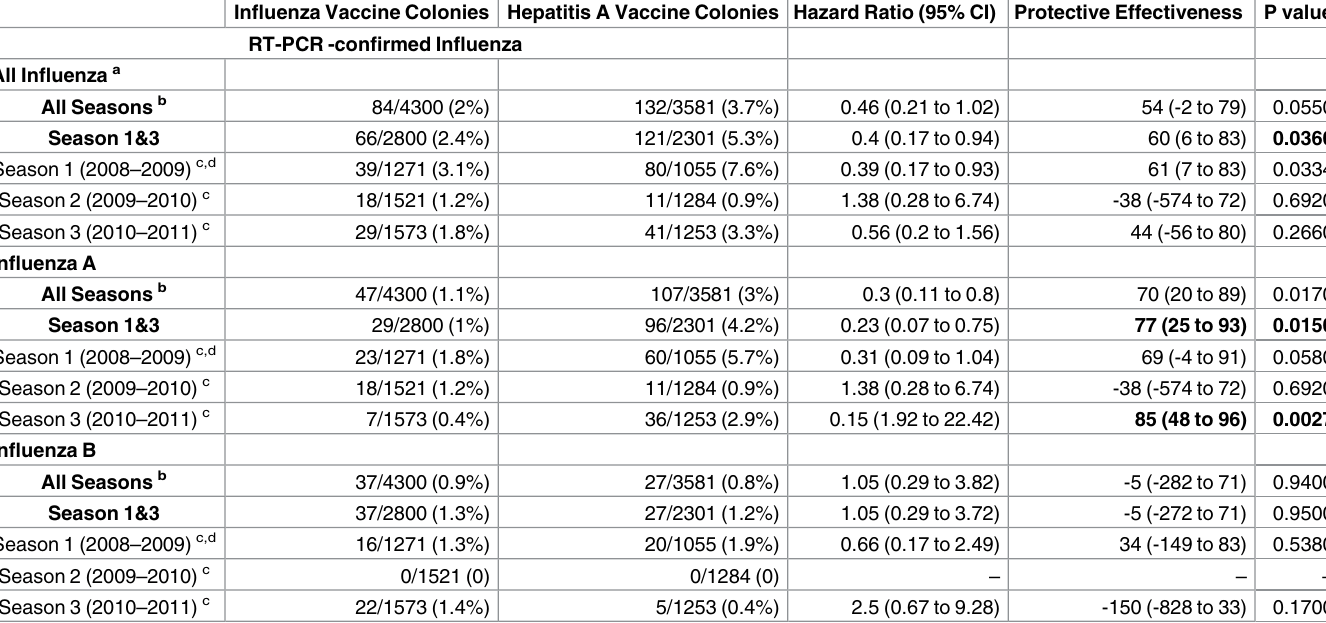
Table 3. Protective Effectiveness on Nonrecipients of Immunizing Children and Adolescents With Influenza